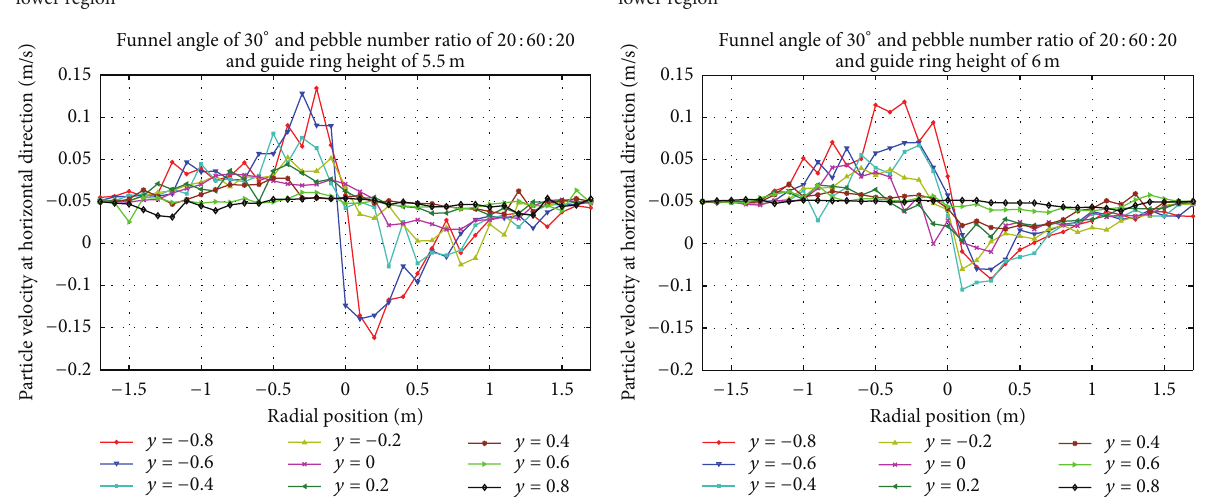
(e) Horizontal velocity distribution of pebbles with guide ring of 5.5m at (f) Horizontal velocity distribution of pebbles with guide ring of 6m at cone region cone region Figure 10: Horizontal velocity distributions of pebbles with different heights of the guide